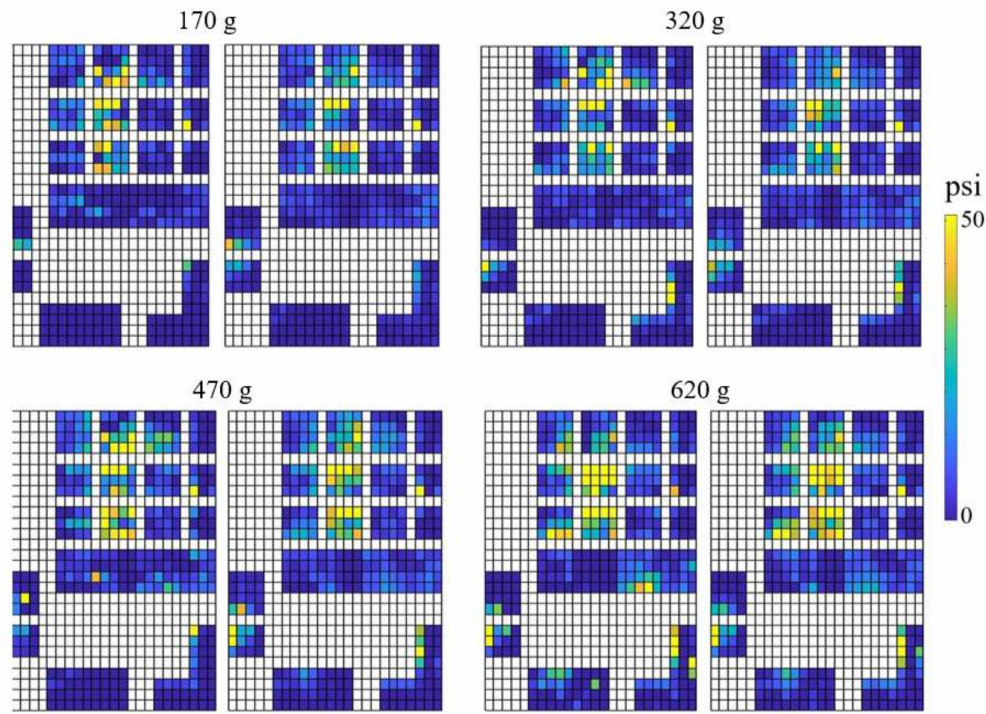
Figure 5. Reconstructed spatial force maps for whole hand grasp for four different weights using the first two synergies for Subject 6. Most of the force intensity is concentrated at the thumb and middle fingertips when holding the object at 170 g. The reconstructed maps using only two synergies could successfully capture the dominant force zones. When extra weights are added to the objects, the force zone enlarges, and fingers involved in the grasp increase. The color bar indicates the scale of the contact forces. Increase in the color bar scale indicates increase in the forces due to increase in the weights. The scale psi indicates pound force per square